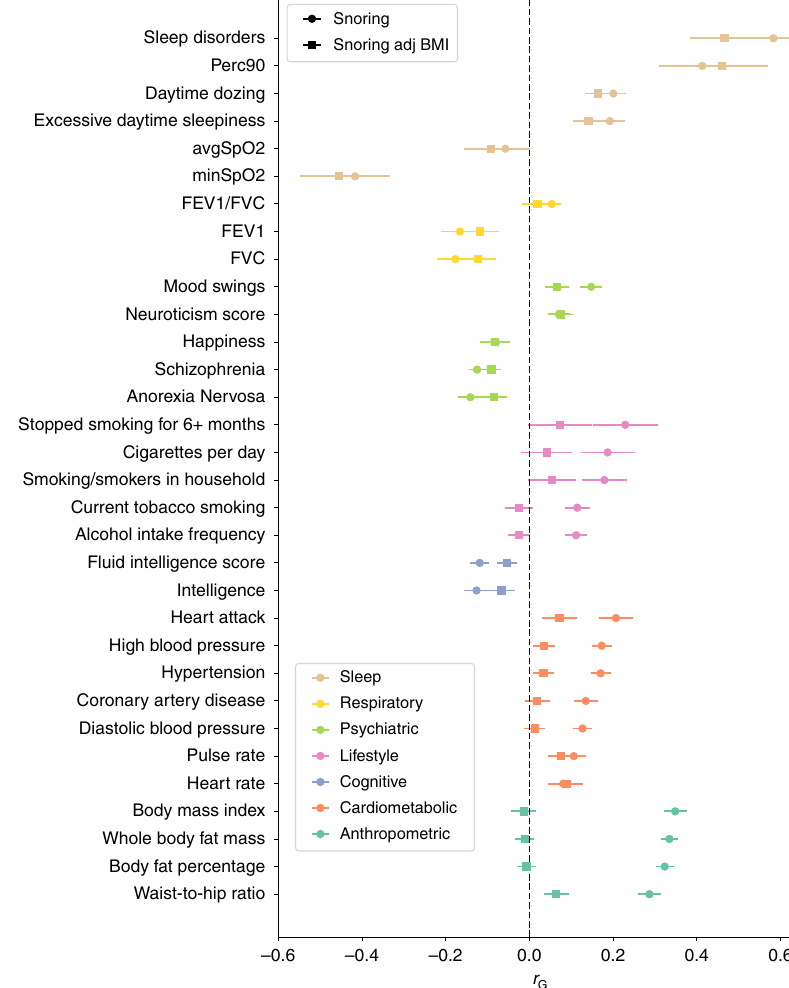
median analyses supported a causal effect of BMI (and whole- body fat mass) on snoring. Notably, although the MR-Egger estimates did not reach statistical signi fi cance, the Egger intercept was not signi fi cantly different from zero.